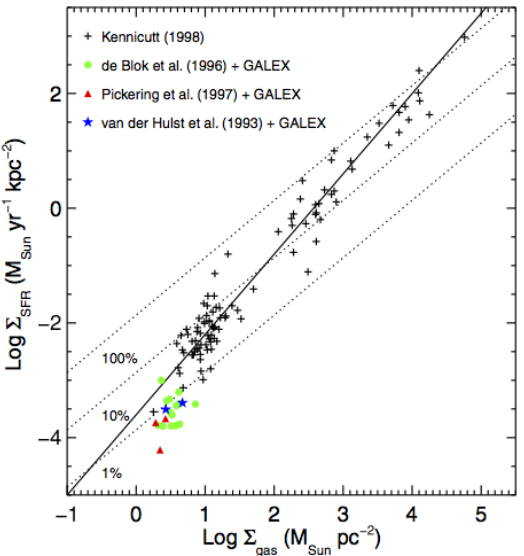
Figure 14. Star formation rate surface density as a function of the HI surface density. LSBs from [150]. Gas surface densities from HI data: [200] (green circles), [233] (red triangles), and [34] (blue stars). HSBs data (pluses) from [219] with their power-law fit (solid line). The dotted lines show the relationship at a constant star formation efficiency of 100%, 10%, 1%, in a timescale of star formation of 10 8 yr. Image reproduced from [150].